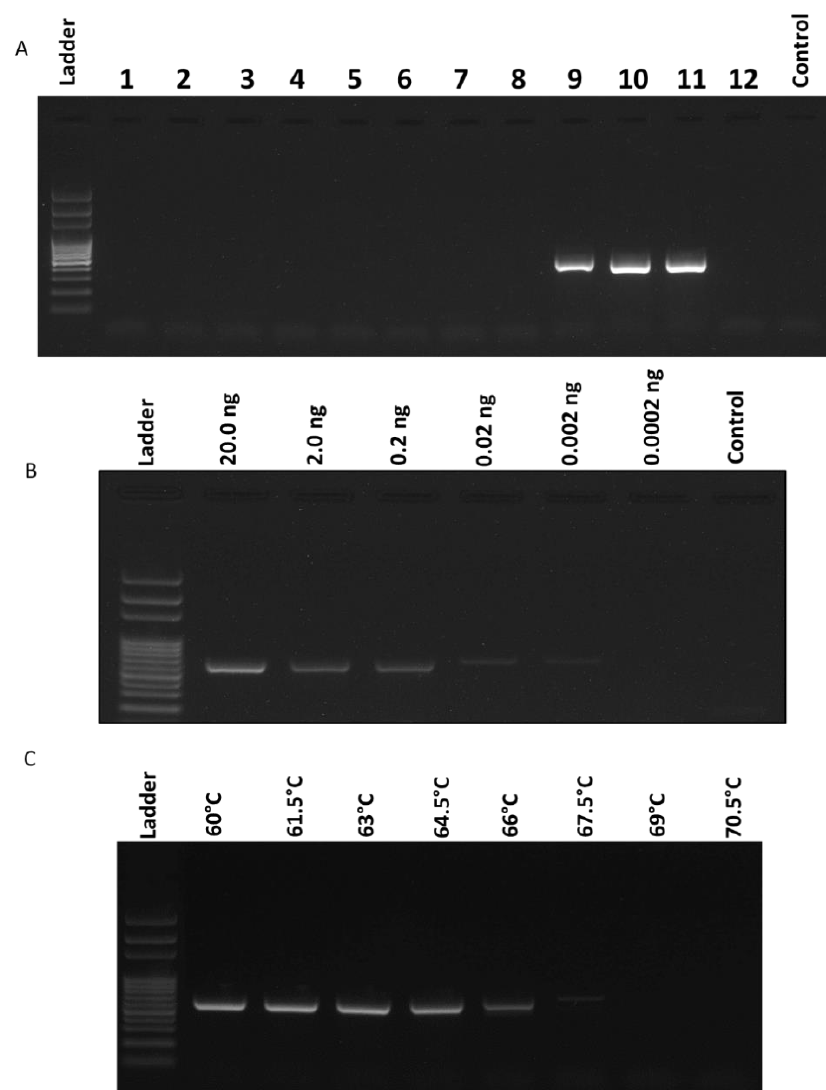
Figure 2. Optimization of the developed marker. ( A ) Non-target amplification of FNR3-F/FNR3-R. Sample numbers correspond accordingly: 1. Phytophthora capsici , 2. Phytophthora sojae , 3. Pseudoperonospora cubensis , 4. Cucurbit leaf crumple virus , 5. Rhizoctonia solani , 6. Colletotrichum orbiculare , 7. Fusarium solani , 8. F. oxysporum f. sp. vasinfectum , 9. F. oxysporum f. sp. lycopersici , 10. Fusarium oxysporum f. sp. niveum (FON) race 1, 11. FON race 2, 12. FON race 3, and control = negative. ( B ) Sen- sitivity determination of FNR3-F/FNR3-R using a serial dilution of FON DNA. DNA concentrations ranged from 20 ng/µL to 0.2 pg/µL. PCR positive bands amplified samples as low as 2.0 pg/µL. ( C ) Gradient PCR results to optimize annealing temperature. Temperatures ranged from 60 to 70.5 °C. The optimized temperature was 63 °C.